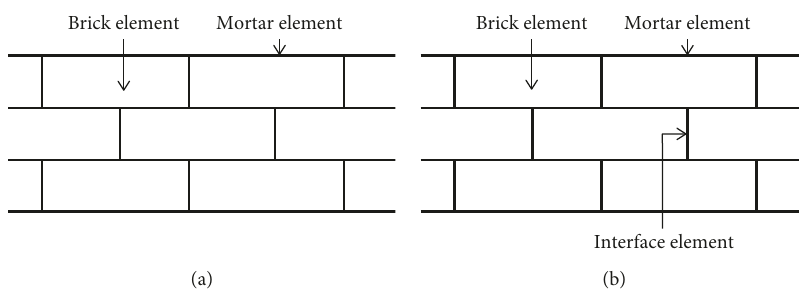
Figure 4: Micromodeling method: (a) simplified micromodeling; (b) detailed micromodeling.